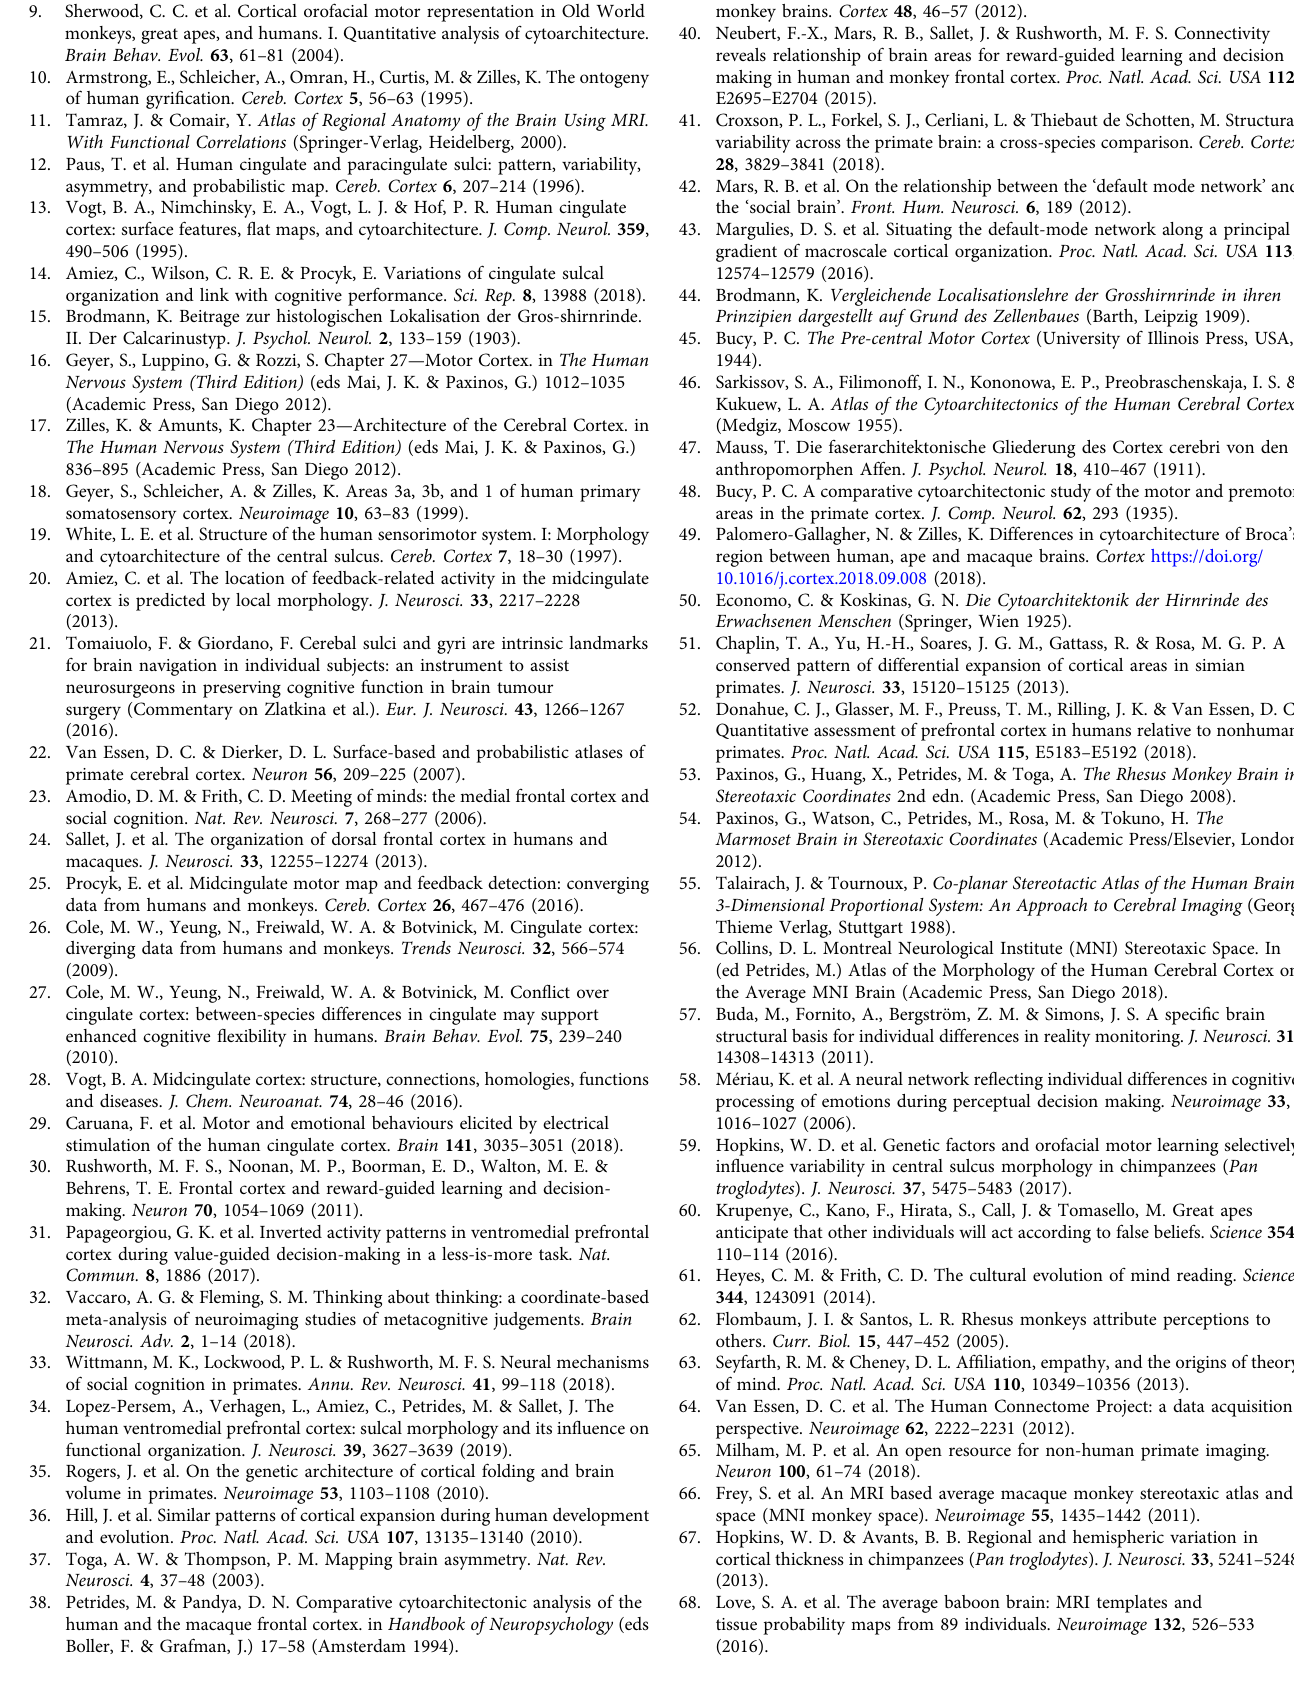
8. Petrides, M. The Human Cerebral Cortex: An MRI Atlas of the Sulci and Gyri in MNI Stereotaxic Space (Academic Press, New York